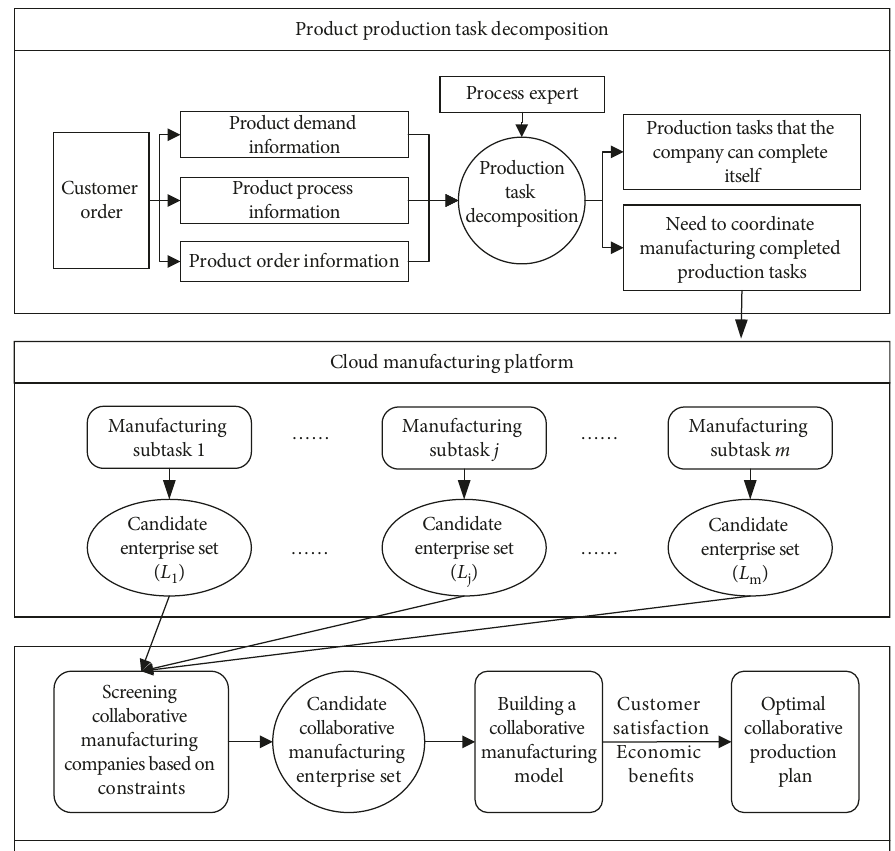
Figure 1: The process of manufacturing resources optimization